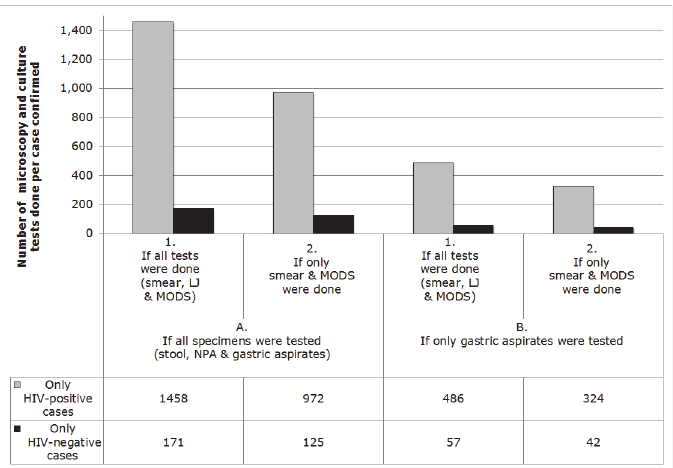
Fig 4. The number of tuberculosis (TB) microscopy and culture tests done for each case confirmed. A. All cases had duplicate stool, nasopharyngeal aspirate (NPA) and gastric aspirate specimens tested for tuberculosis (TB) by auramine microscopy (smear), Lowenstein-Jensen (LJ) solid culture, and microscopic- observation drug-susceptibility (MODS) liquid culture [e.g. the left-most gray bar indicates that in this study 1458 tests (1. smear, LJ and MODS) were done (on A. stool, NPA and gastric aspirates) per HIV-positive case diagnosed; whereas the right-most black bar indicates that in this study if only (2.) smear and MODS testing had been done on only (B.) duplicate gastric aspirates then 42 tests would have been done per HIV- negative case